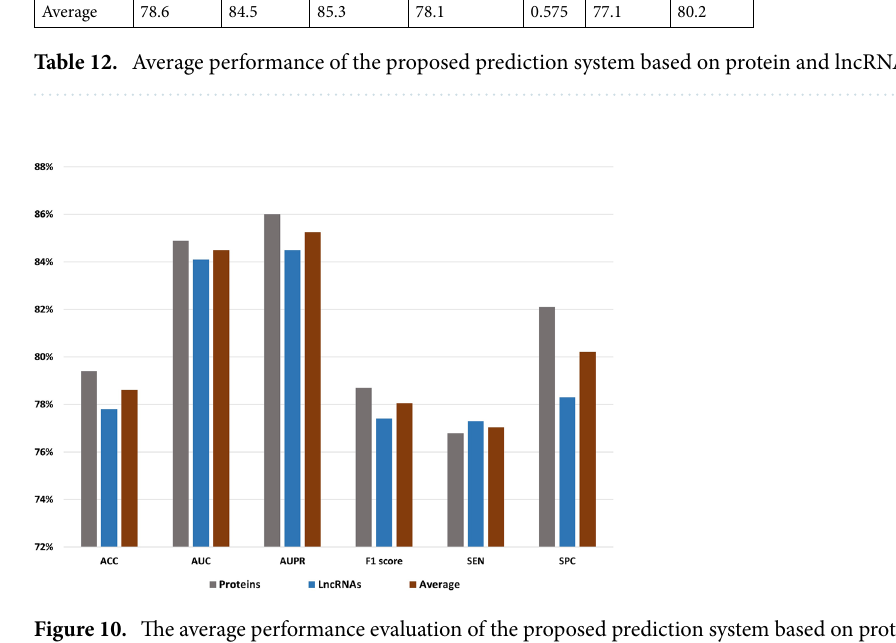
Figure 10. The average performance evaluation of the proposed prediction system based on protein and lncRNA